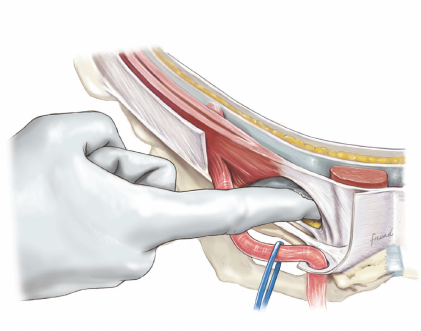
Figure 6: The index finger is used to plunge through the transver- salis fascia into the preperitoneal space.